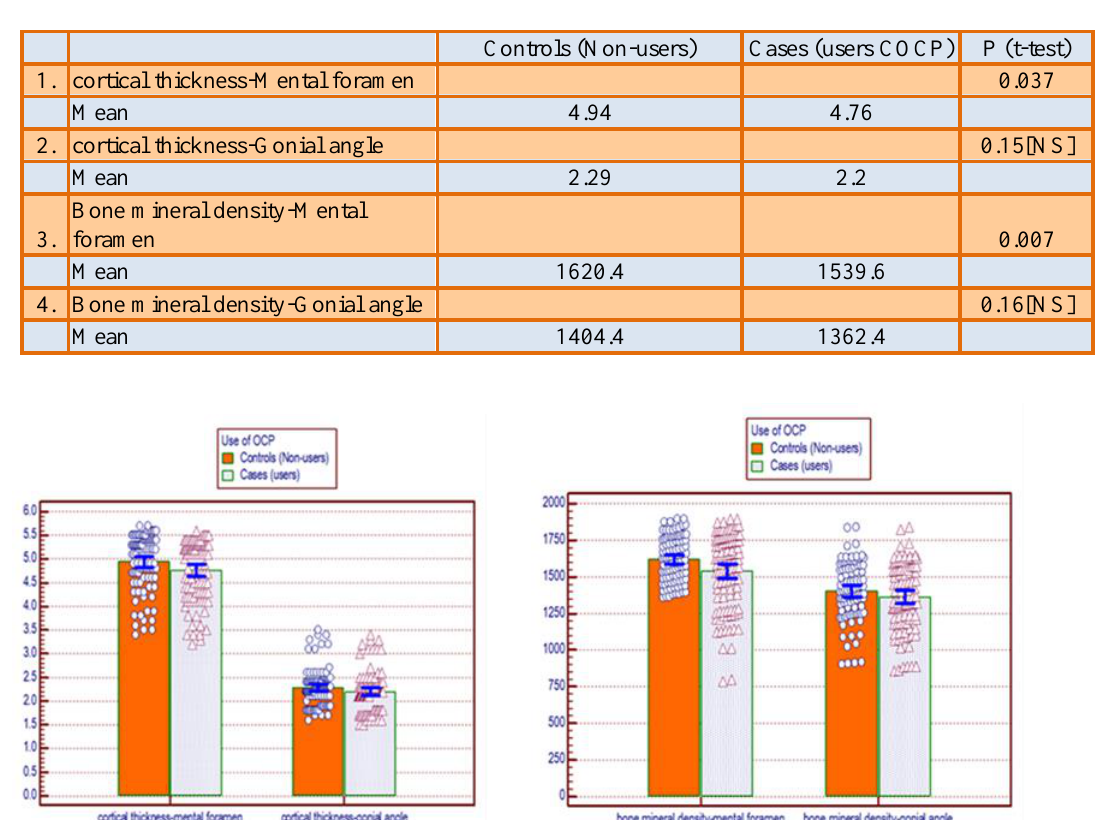
Table1: The difference in mean cortical thickness and BMD at two selected mandibular location between users and non-users of COCP